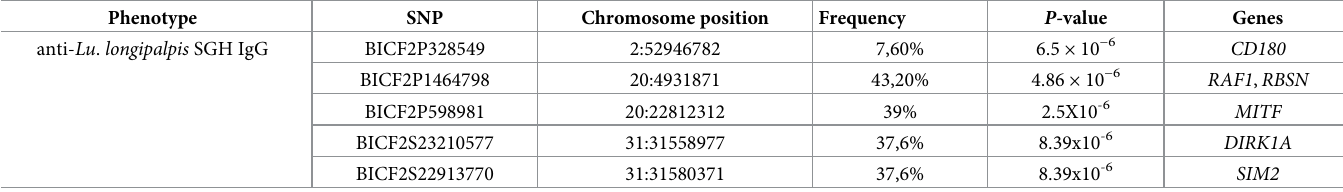
Table 2. Position, frequency, and significance of significantly associated SNPs and positional candidate genes potentially associated with the phenotypes.